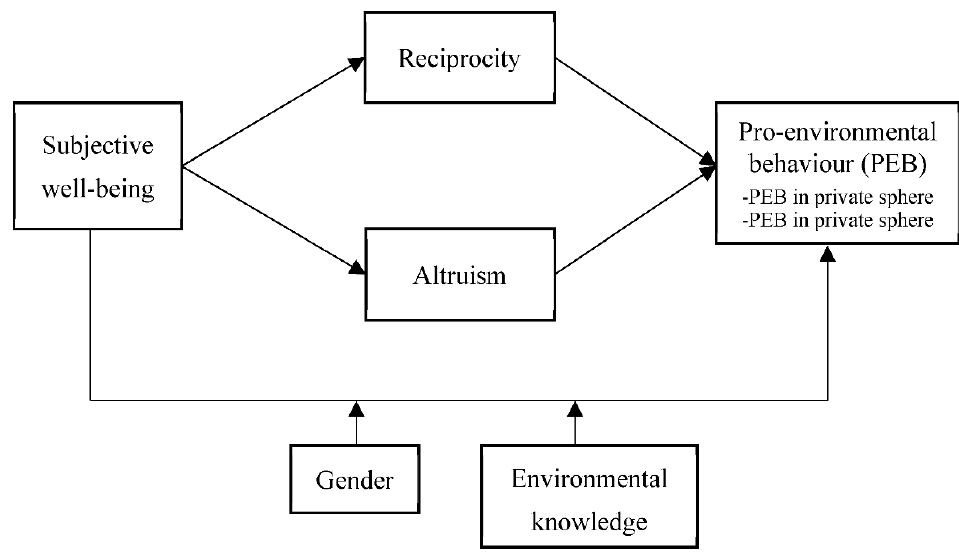
Figure 1. The theoretical framework.